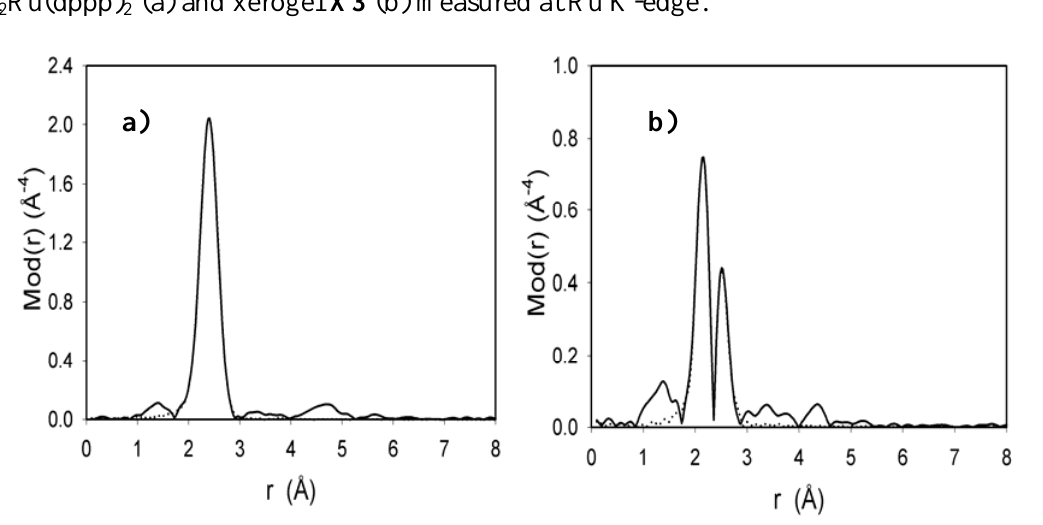
Figure 7. Experimental (solid line) and theoretical (dotted line) Fourier Transform plot